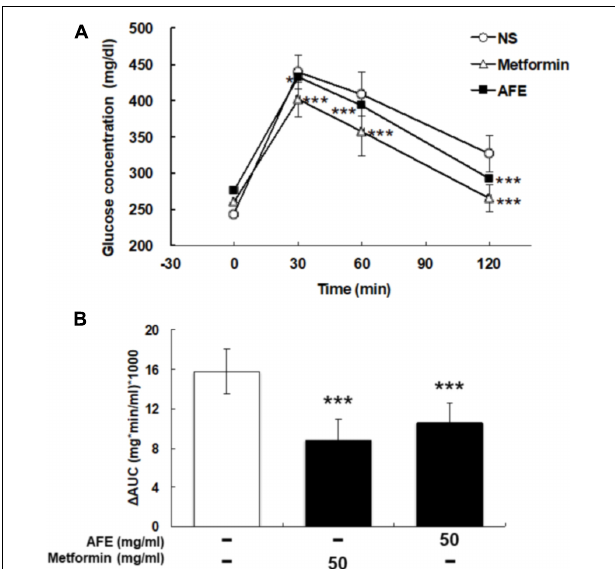
FIGURE 3 | Effect of AFE-reduced blood glucose is comparable to that of metformin in hyperglycemic mice. Hyperglycemic mice were injected with metformin (50 mg/kg) or AFE (50 mg/kg) intraperitoneally. Glucose was injected intraperitoneally after metformin or AFE administration. Blood glucose was measured at 0, 30, 60, and 120 min after glucose administration. (A) The time courses of blood glucose concentration measured in fructose-induced hyperglycemic mice treated with metformin and AFE (50 mg/kg). NS: treated with normal saline as control. Data are shown as mean ± SD ( n = 16). ∗ p < 0.05, ∗∗∗ p < 0.001, compared to untreated control group. (B) Measurement of the area under the incremental blood glucose concentration curve in the glucose tolerance test of the experimental group mice. –: treated with normal saline as control; 50: treated with metformin or AFE 50 mg/kg. Data are shown as mean ± SD of each group ( n = 16),